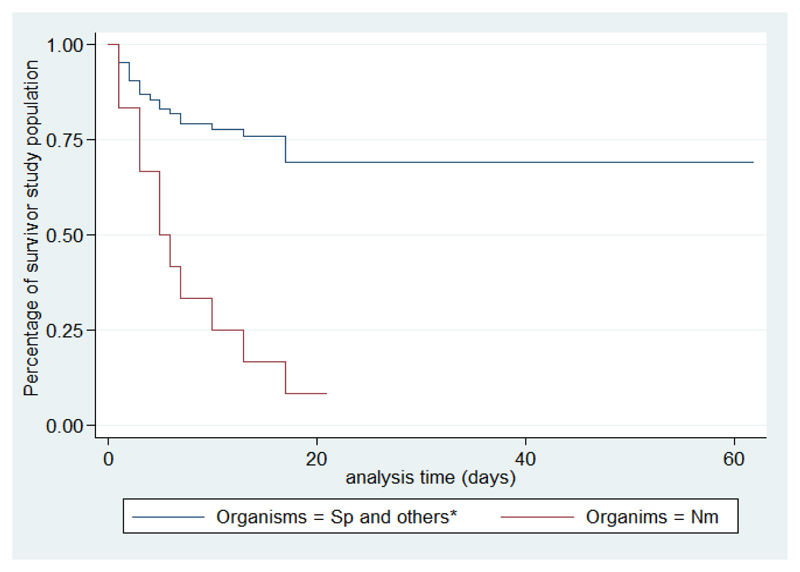
Survival analysis curves according to organisms*Only Streptococcus pneumoniae and Nesseira meningitidis were found in the cases, other germs are Streptococcus B, Staphylococcus aureus and E. coli, no Haemophilius was found.